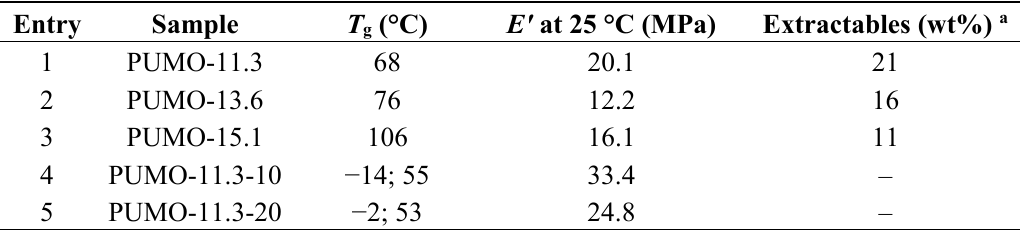
Table 3. DMA results for PUs from MO and their corresponding